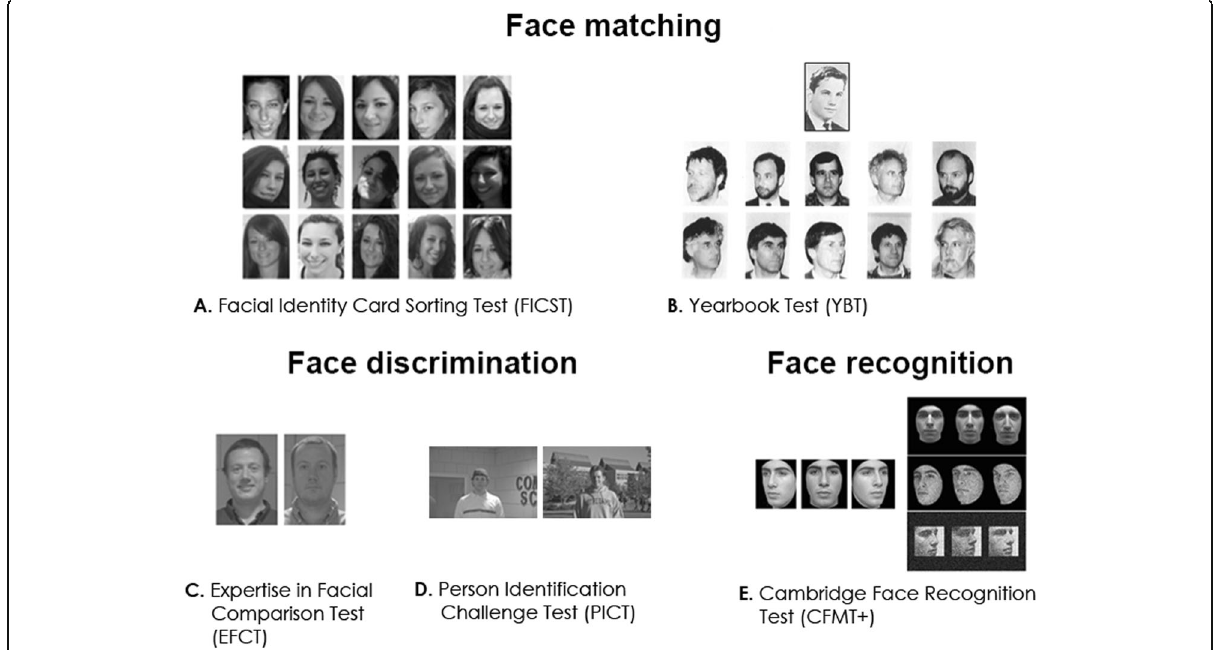
Fig. 1 Examples of stimulus material presented in the tests of face processing administered in this study. Observers completed tests of face matching involving naturally occurring a image-related (FICST; Jenkins et al., 2011), or b aging-related variations (YBT; Bruck, Cavanagh, & Ceci, 1991). Additional measures included previously established tests of c , d face discrimination (EFCT and PICT; White et al., 2015), and e recognition (CFMT+; Russell et al., 2009). Note that these illustrations are for demonstration purposes and may differ from the stimulus material used (detailed descriptions are provided in the methods section). Consent/rights for publication obtained for individuals